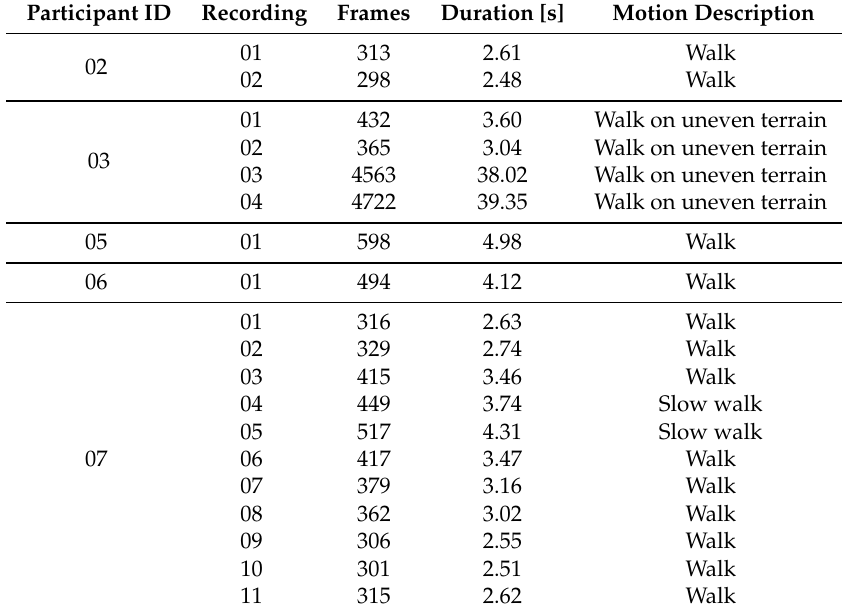
Table A6. List of the 42 participants and recordings used from the CMU dataset [49] to create dataset A